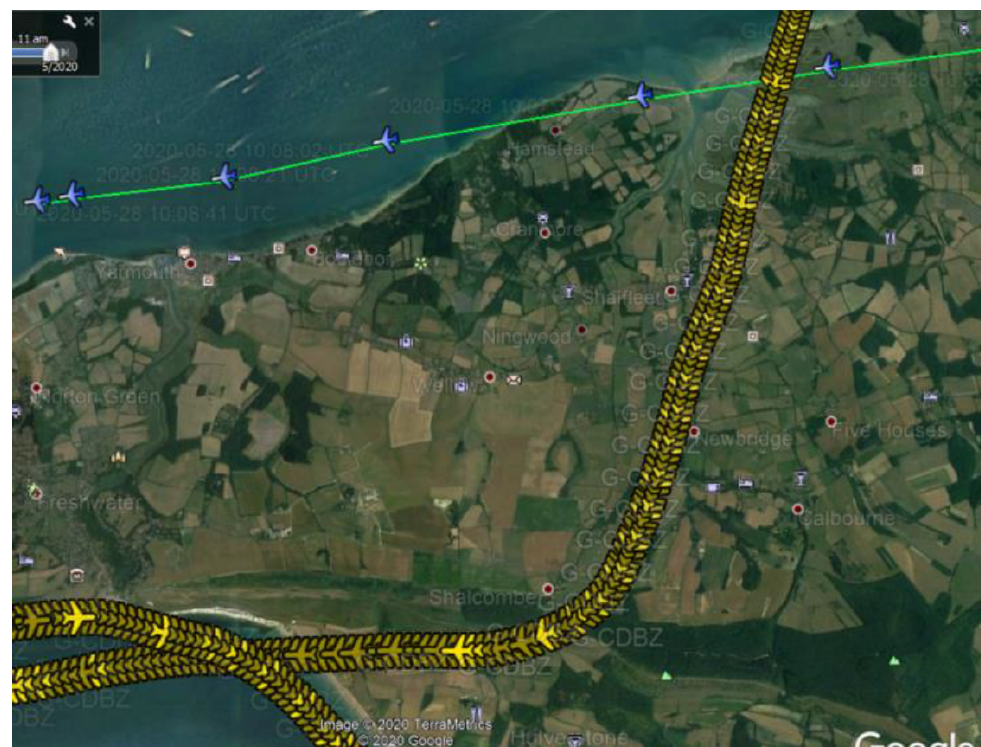
Figure 22. A comparison between current SSR transmissions (blue) and the transmissions from the devices used in this project